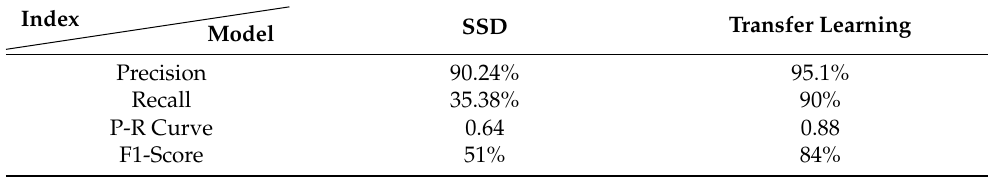
Table 2. Experimental evaluation results.